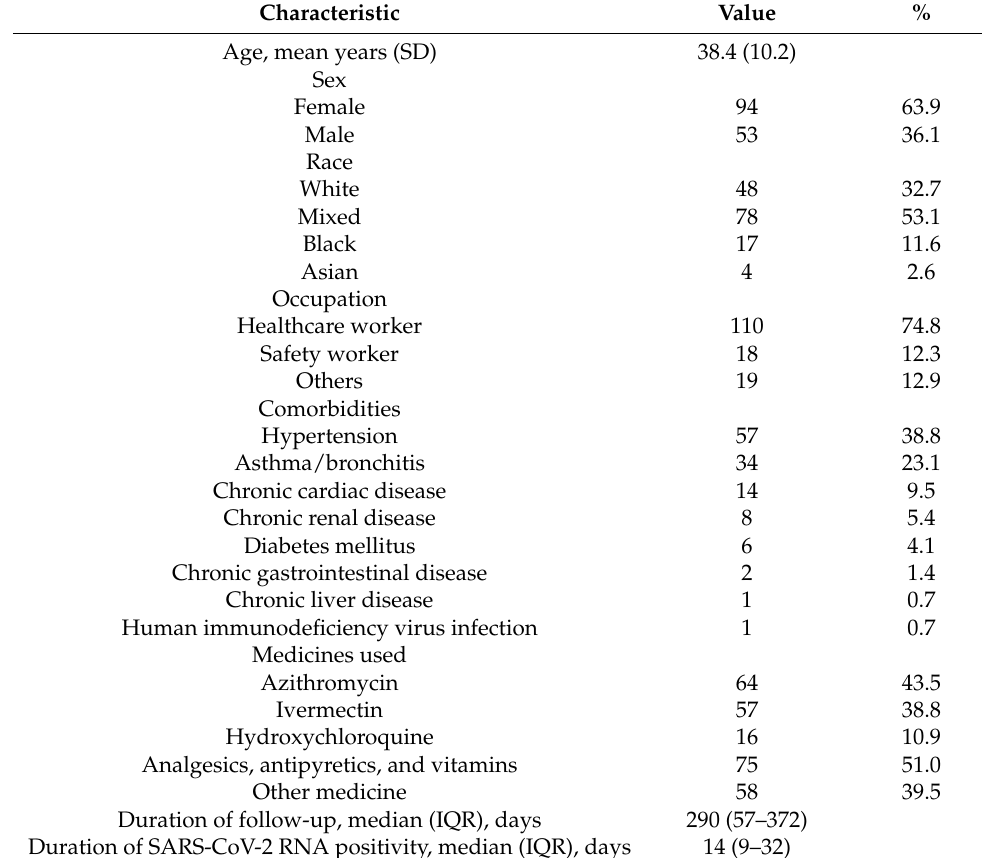
Table 1. Characteristics of 147 healthcare and safety workers diagnosed with coronavirus disease 2019 (COVID-19) in central Brazil. Characteristic Value % Age, mean years